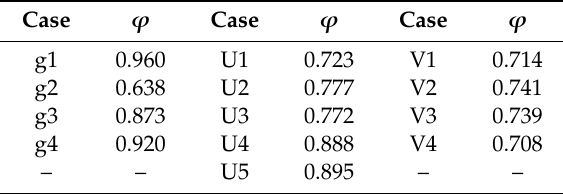
Table 1. The index of model validation.